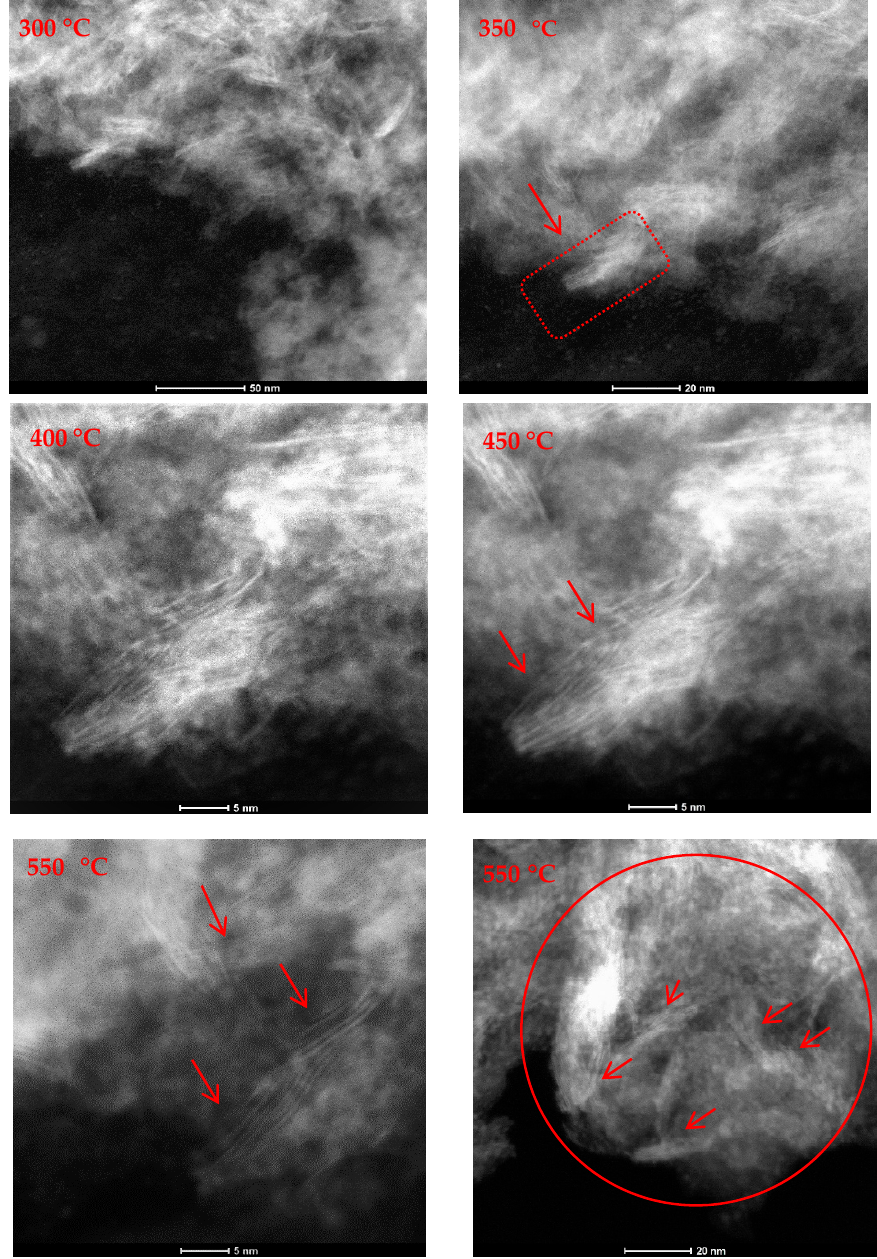
Figure 2. A series of STEM images acquired during in-situ heating at 300 °C, 350 °C, 400 °C, 450 °C, 500 °C and 550 °C as labeled. One can observe c-stacking of S-Mo-S two-dimensional layers, even at of 550 °C, with interplanar distances of ~0.62 nm; also the spherical shape remains as indicated by red-circle on image corresponding to stage at 550 °C.